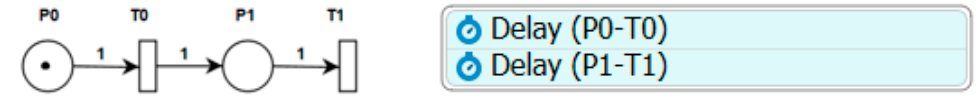
Figure 5. Sequential execution in Petri net (left) and FlexSim (right).